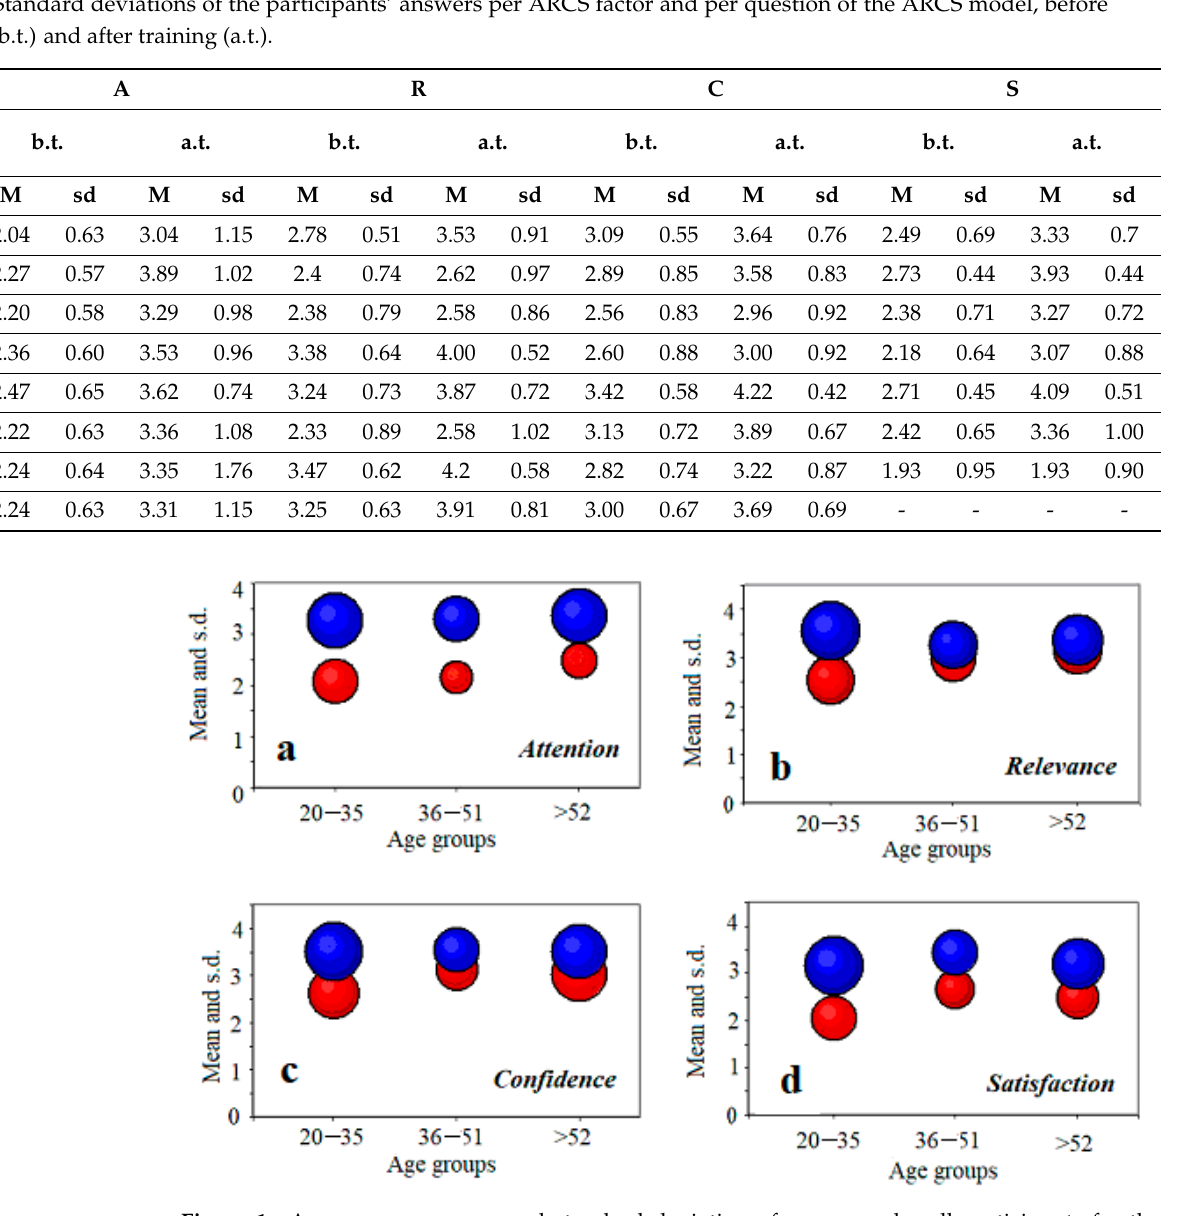
Figure 1. Average mean score and standard deviation of responses by all participants for the 31 questions per factor of the ARCS model, before training (lower row) and after training (upper row) per age group (ball sizes are proportional to standard deviation): Attention ( a ), Relevance ( b ), Confidence ( c ), Satisfaction ( d ).